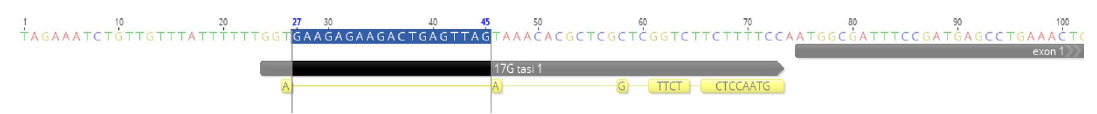
Figure 2. A simple scheme to show 5 ′ UTR and start of CDS in Glyma.13G106100.1 and 17G tasi target in which match on